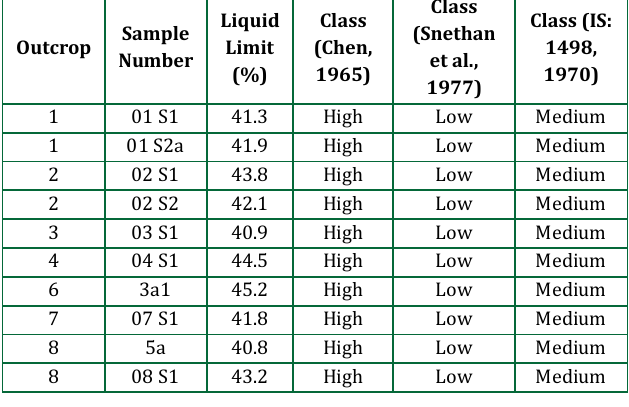
Table 5: Swell potential classification of mudstones based on liquid limit (Class limits after Chen, 1965; Snethan et al.; 1977; IS:1498, 1970)